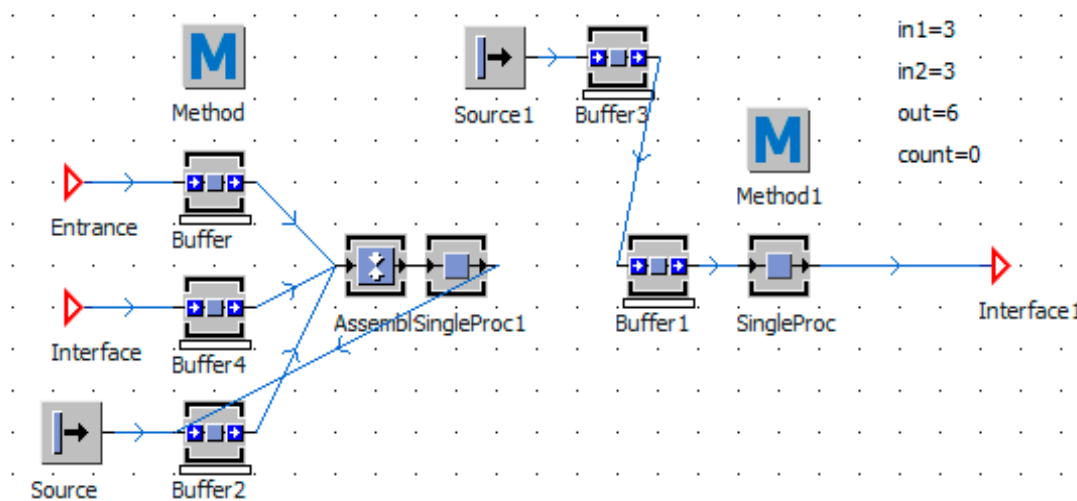
Figure 5. Mixed-process machine simulation composition diagram.